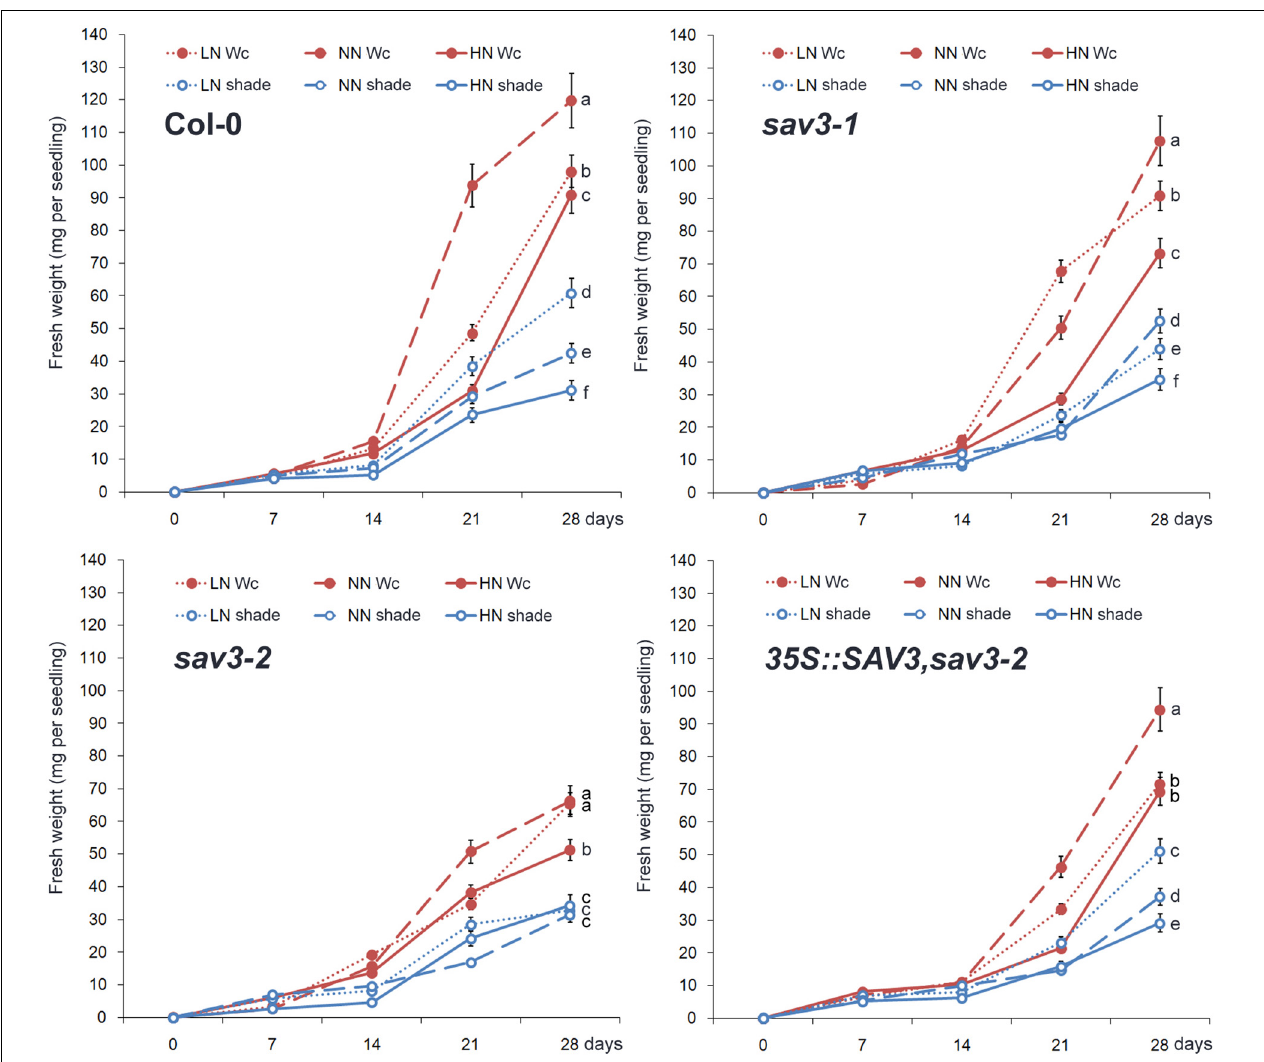
FIGURE 5 | Plants grew fastest under normal N condition and continuous white light. Fresh weight increasing of wild-type (Col-0), sav3-1 , sav3-2 , and 35S::SAV3,sav3-2 seedlings grown under different N levels with or without shade treatment were recorded every week. Wc, continuous white light; LN, low N condition; NN, normal N condition; HN, high N condition. Bars represent standard deviations of 15 independent replicates. Values at 28th day followed by different letters are significantly different at P < 0.05 according to Duncan’s multiple range test.